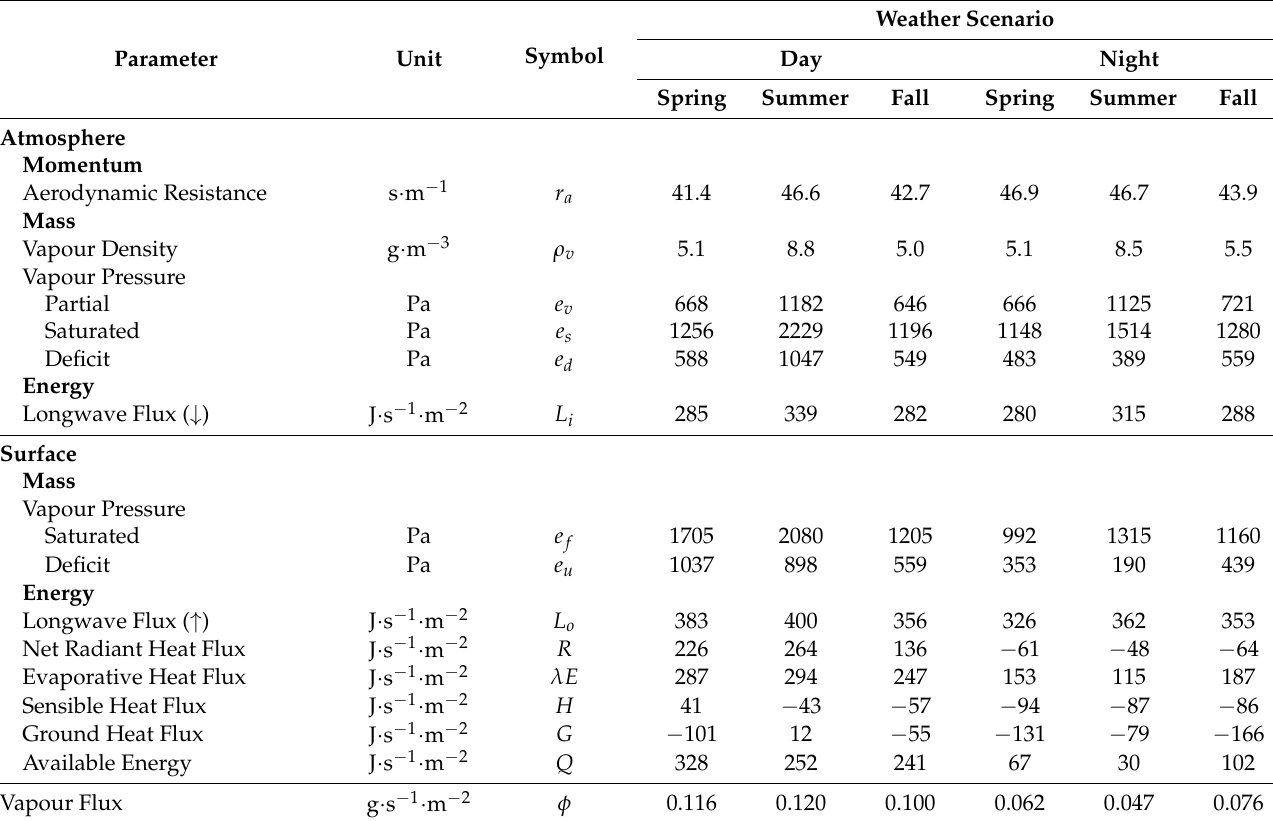
Table 3. Summary of average atmospheric and water surface parameter analyses.